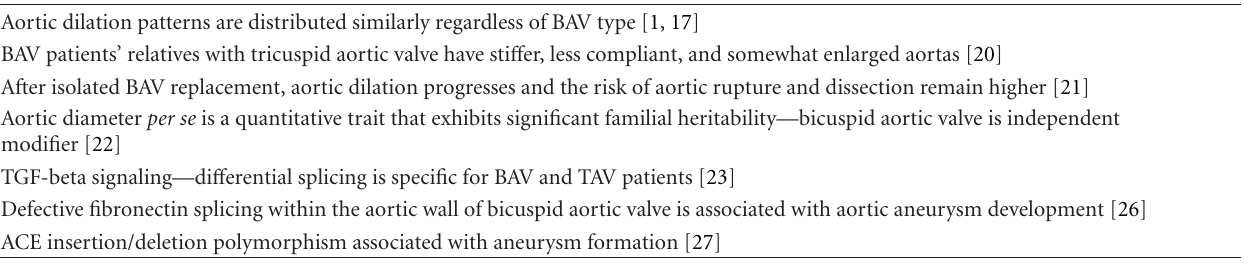
Table 2: Hereditary factors—longitudinal extent—arch involvement of